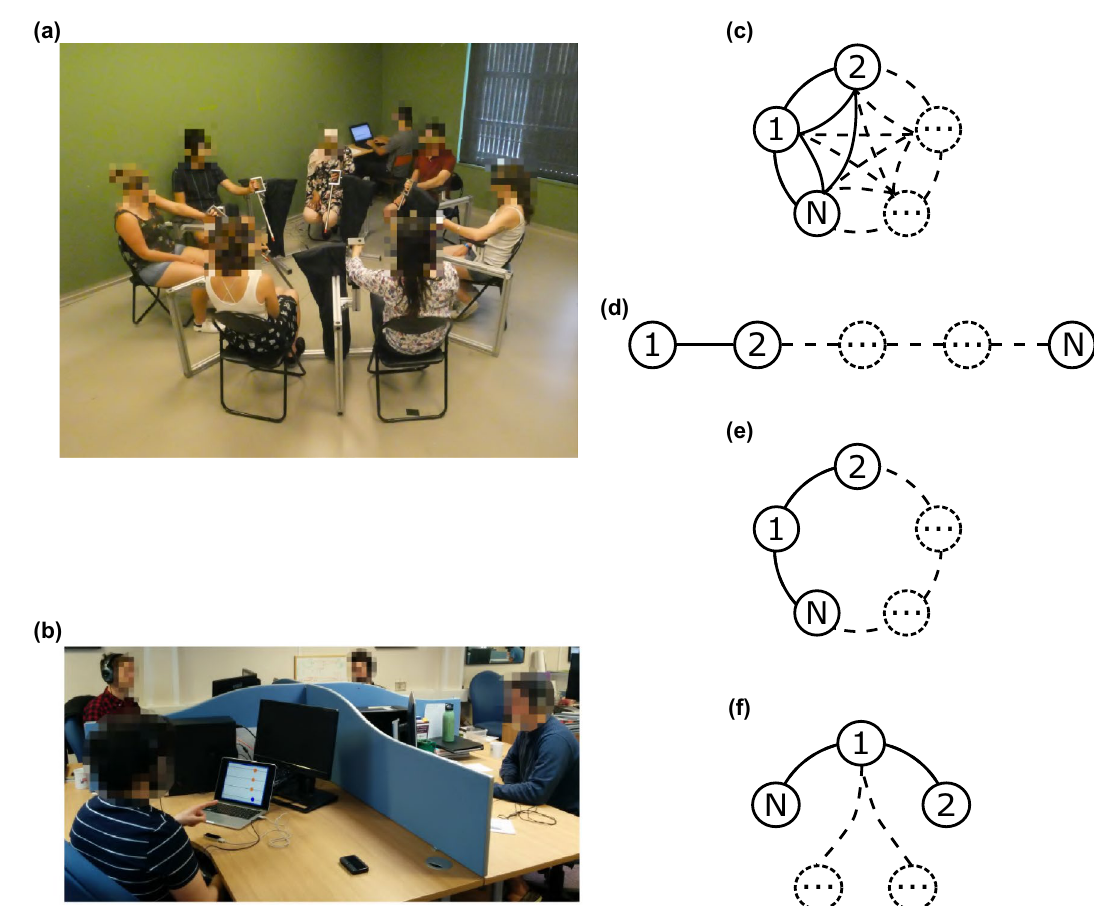
Figure 1. Experimental setup. ( a ) The panel describes the first setup ( Experiment 1: pendula ), where each player was asked to move a pendulum with their own preferred hand and try to synchronize its movement with the others (see “Methods” for more details). ( b ) The second setup ( Experiment 2: Chronos ), where participants had to oscillate and synchronize the index finger of their preferred hand over a Leap Motion controller (Leap Motion, Inc. 34 ) while being virtually connected with the others through the platform Chronos 33 . The main difference with the previous setup is the absence of visual and acoustic coupling among the players due to physical separators and headphones, so as to cancel or minimize social interactions. ( c – f ) We plotted the four